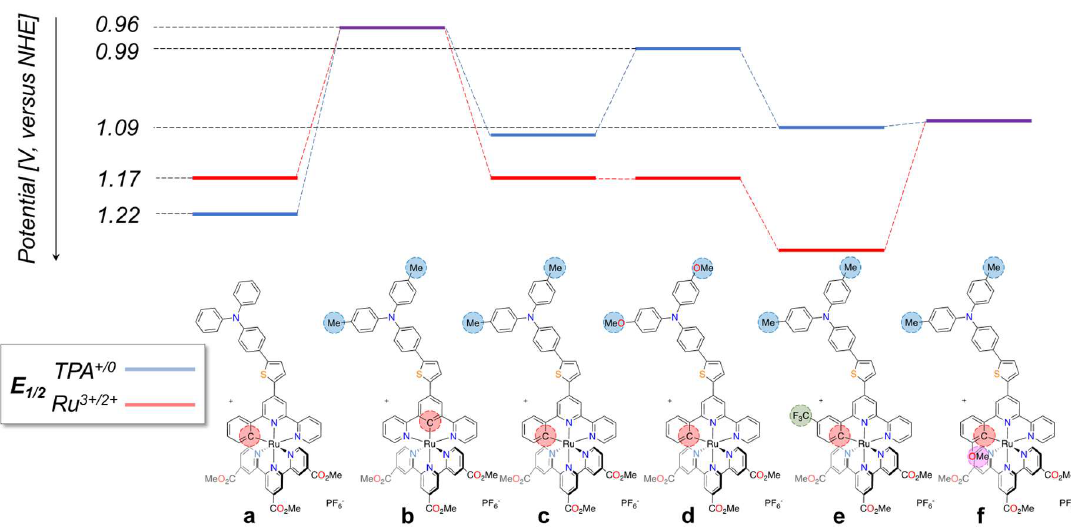
Figure 15. Control over Ru 3+/2+ and TPA +/0 oxidation potentials. Upon introduction of methyl and methoxy substituents from a , to b , and d the oxidation potential of TPA shifts cathodically while for the Ru center it remains undisturbed. Introduction of trifluoromethyl/methoxy substituents at the cyclometalating ring shifts anodically/cathodically the Ru 3+/2 oxidation potential while not disturbing TPA oxidation potential as seen comparing values for c , e , and f . Data for c and d versus b reveal that dpb is more electron reach cyclometalating ligand than pbpy. The figure is build based on data provided in literature [107,120] .